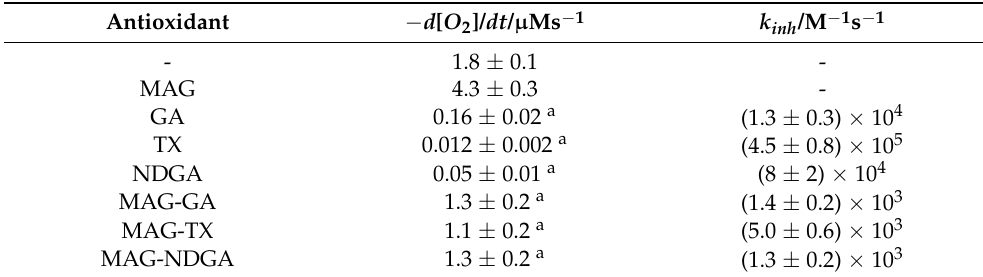
Figure 5. Oxygen consumption measured during the autoxidation of styrene (4.3 M) in MeCN, initiated by AIBN (25 mM) at 30 °C, in the absence of inhibitors (a, dashed line) or in the presence of the investigated antioxidants: Panel ( A ): MAG@NDGA (b), MAG@GA (c), MAG@TX (d), (all 0.25 mg/mL); Panel ( B ): NDGA (0.54 mM) (b), GA (0.83 mM) (c), TX (0.40 mM) (d), corresponding to the phenol concentration of the experiments reported in Panel ( A ). Table 2. Rates of O 2 consumption during AIBN-initiated styrene autoxidation and rate constants for the reaction with peroxyl radicals (ROO •